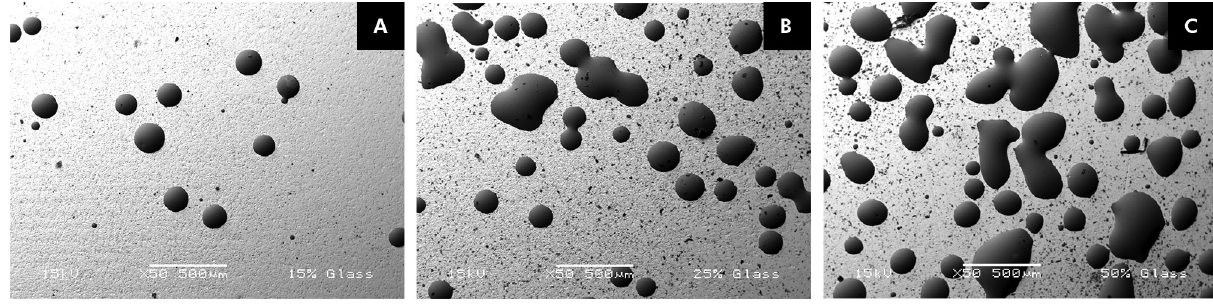
Figure 4. The increase in the amount of glass on the zirconia surface for G2, G3 and G4 can be seen respectively in images A, B and C (back-scattering electron detector). Individual fused glass beads are shown in Image A, and groups of beads fused together can be seen in images B and